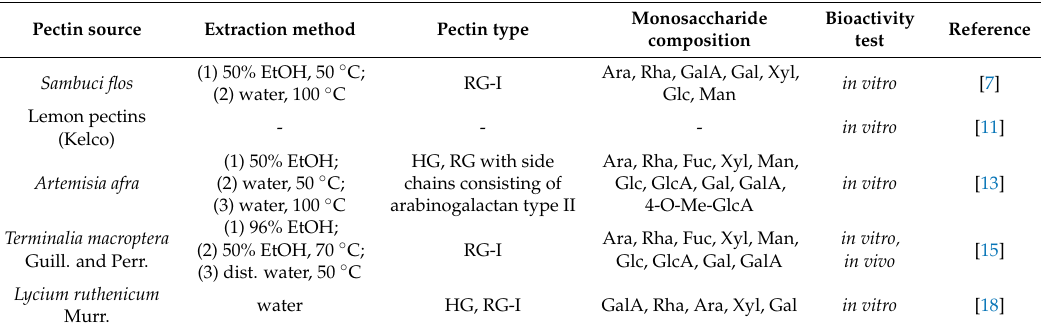
Table 1. Immunoregulatory activity of pectins. HG: homogalacturonan, RG-1: rhamnogalacturonan I. Pectin